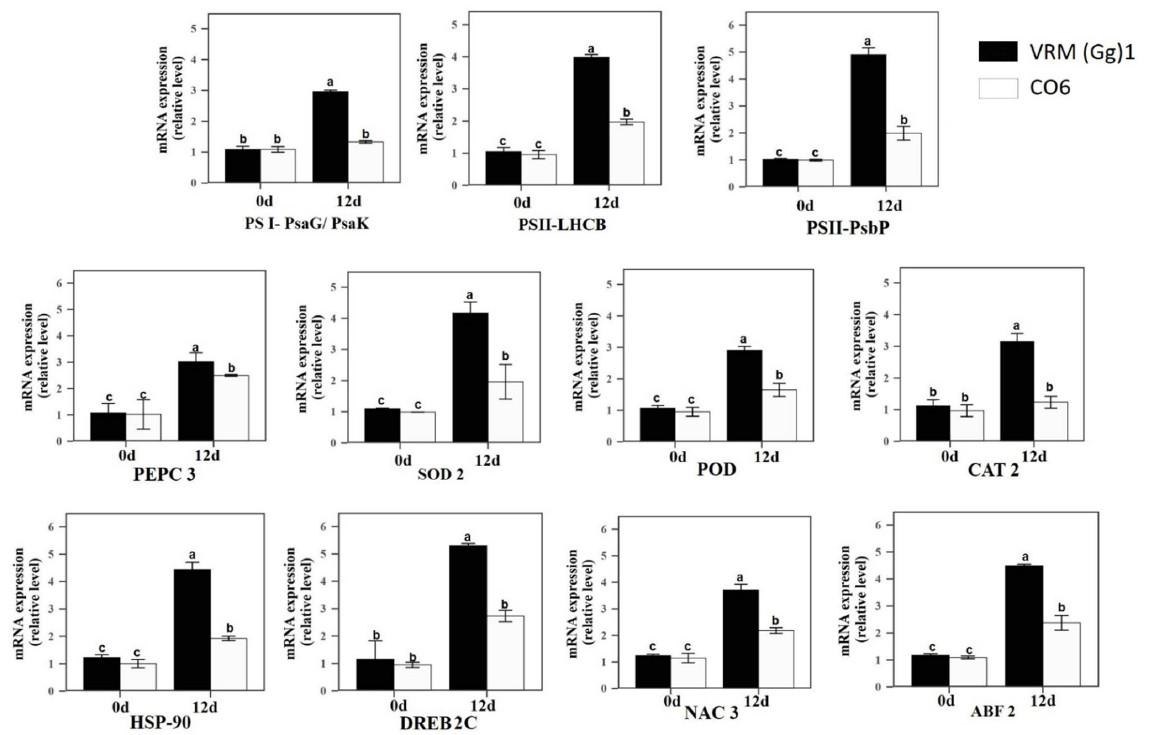
Figure 4. Effect of drought stress on the relative expression level of photosynthesis ( PS II-PsbP, PS II-LHCB, PS I-PsaG/PsaK, and PEPC 3 ), antioxidants ( SOD 2, POD, and CAT 2 ), and stress ( HSP-90, DREB2C, NAC 3 and AREB 2 ) related genes in two mungbean cultivars VRM (Gg) 1 and CO6. Values followed by the same letter are not significantly different ( p ≤ 0.05) according to duncan’s multiple range test. Bars present means ± SE ( n = 3).